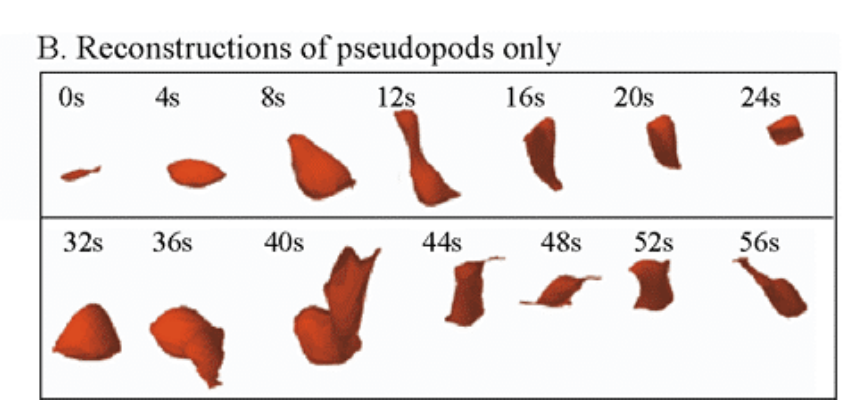
context for assessing the role played by a particular gene in cell polarity, locomotion, and chemotaxis through mutant analysis. The sum of the characteristics and rules of cell behavior in buffer represents the “basic motile behavior” of a wild type cell. The basic motile behavior of a cell is then manipulated by the temporal, spatial, and concentration components of the natural relayed wave of cAMP to attain directed movement in the process of Dictyostelium chemotaxis. Although such a detailed list has only been developed for wild type Dictyostelium amoebae translocating in buffer, many of these rules and characteristics will no doubt prove common to other translocating animal cells, and are therefore worth considering in